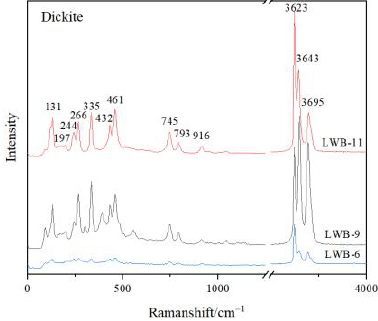
Figure 3. Raman Spectra of dickite, which is the mineral composition of the matrix of the samples.